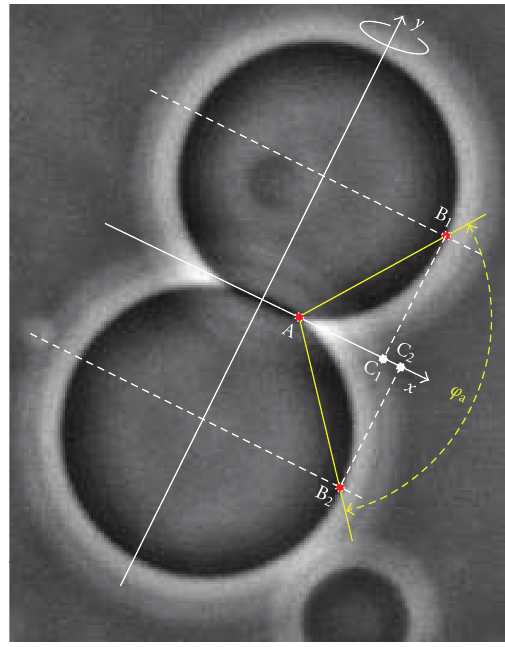
Figure 2: Phase contrast microscope image of the two adhering giant phospholipid vesicles (with radii of approx. 30 μ m). The y - axis denotes the symmetry axis and the x -axis the contact plane. Points A, B 1 , and B 2 are to be located to measure the adhesion angle ϕ a between lines AB 1 and AB 2 . The adhesion angle can be obtained also from measuring lengths: ϕ a = arctan M 1 + arctan M 2 , where M 1 = B 1 C 1 / AC 1 , M 2 = B 2 C 2 / AC 2 , and points C 1 and C 2 are projections of points B 1 and B 2 to the contact